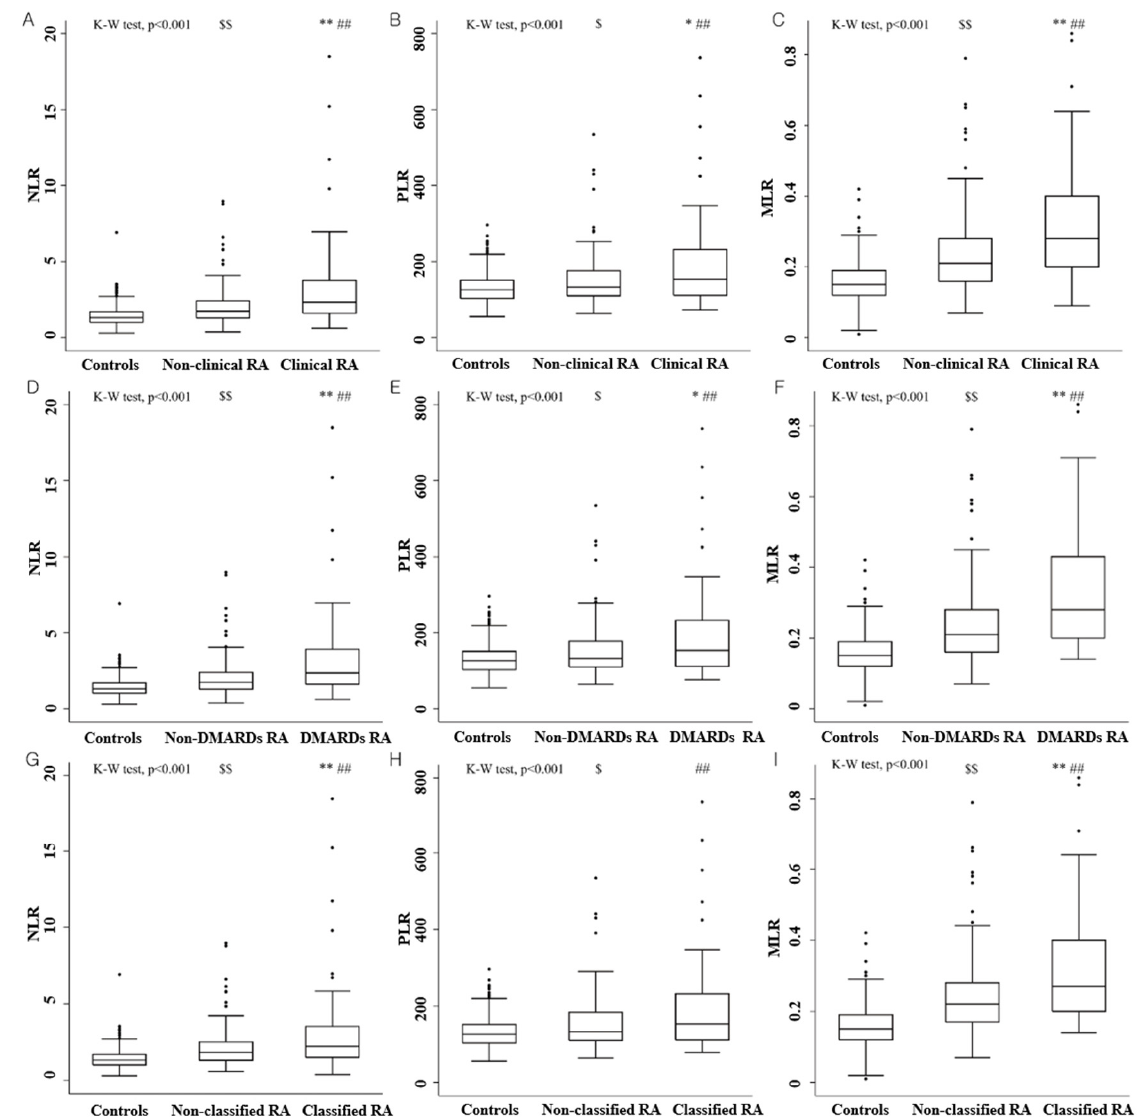
Figure 2. Comparisons of neutrophil-to-lymphocyte (A, D, G), platelet-to-lymphocyte (B, E, H), and monocyte-to-lymphocyte ratios (C, F, I) among healthy controls, early inflammatory arthritis patients without rheumatoid arthritis, and those with rheumatoid arthritis. K–W test: Kruskal–Wallis test, DMARDs: disease-modifying anti-rheumatic drugs, and RA: rheumatoid arthritis. * p < 0.05 vs. non-RA, ** p < 0.001 vs. non-RA, ## p < 0.001 vs. healthy controls, $ p < 0.05 vs. healthy controls, $$ p < 0.001 vs. healthy controls. Table 1. Baseline clinical characteristics between patients with early inflammatory arthritis and healthy controls .